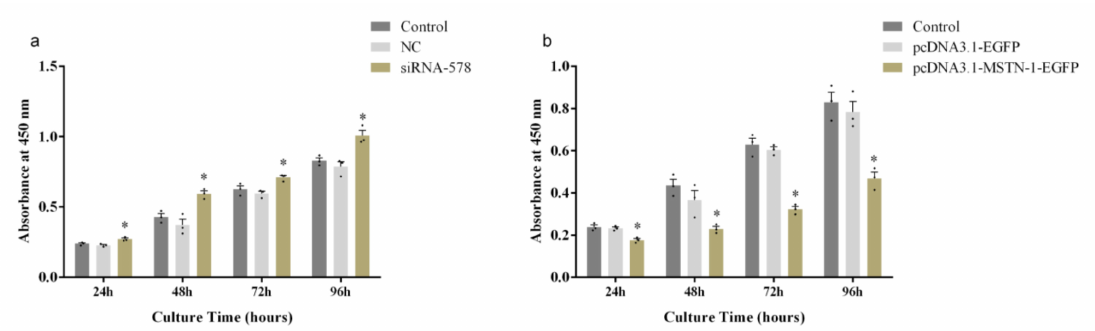
Figure 7. Change of cell proliferation by alternating the expression of mstn-1 . ( a ) Absorbance at 450 nm of the cells from the control group, negative control (NC) group, and siRNA-578 group; ( b ) Absorbance at 450 nm of the cells from the control group, pcDNA3.1-EGFP group, and pcDNA3.1-MSTN-1-EGFP group. The absorbance was measured at 24, 48, 72, and 96 h after incubating in complete medium. * means significantly di ff erent compared with control at the same time point ( p <